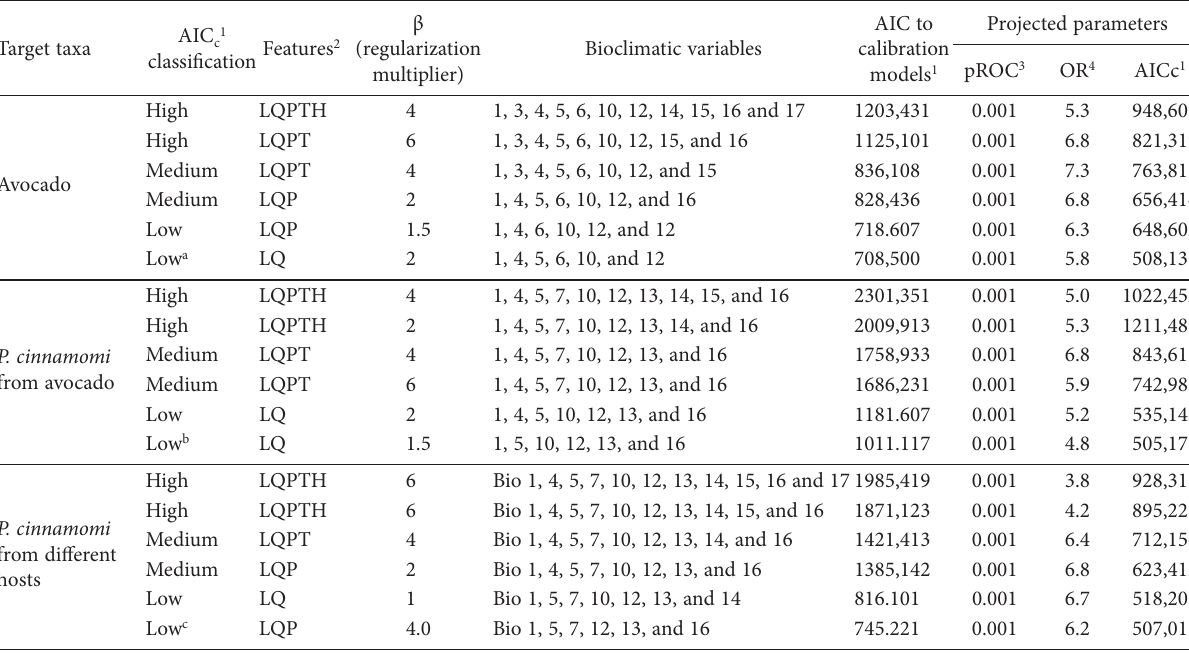
Table 1. Description of selected models and corresponding parameters based on the Maxent algorithm.